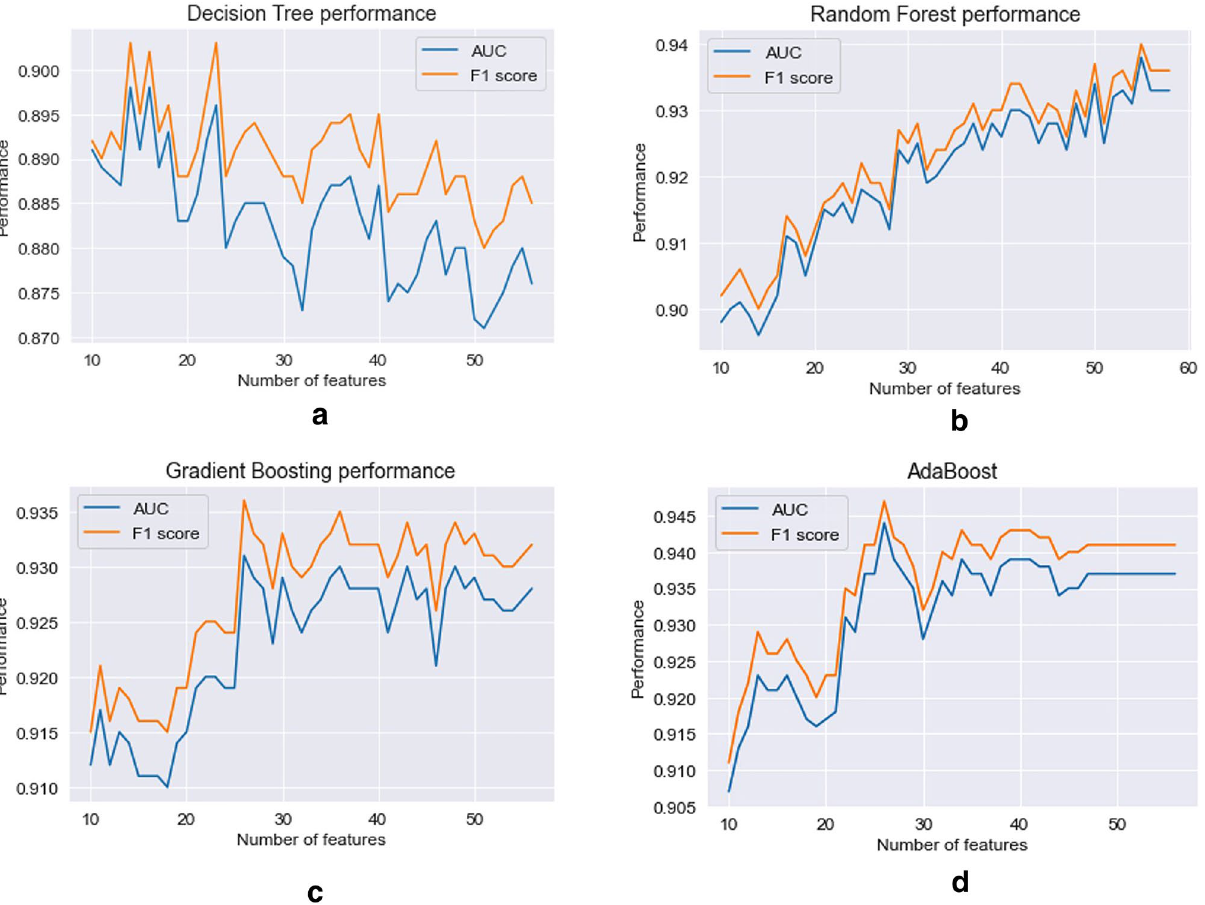
Figure 2. The performance of each model across symptom subsets. Models: ( a )—Decision Tree, ( b )—Random Forest, ( c )—Gradient Boosting Trees, ( d )—AdaBoost. Features are ordered according to each model’s feature